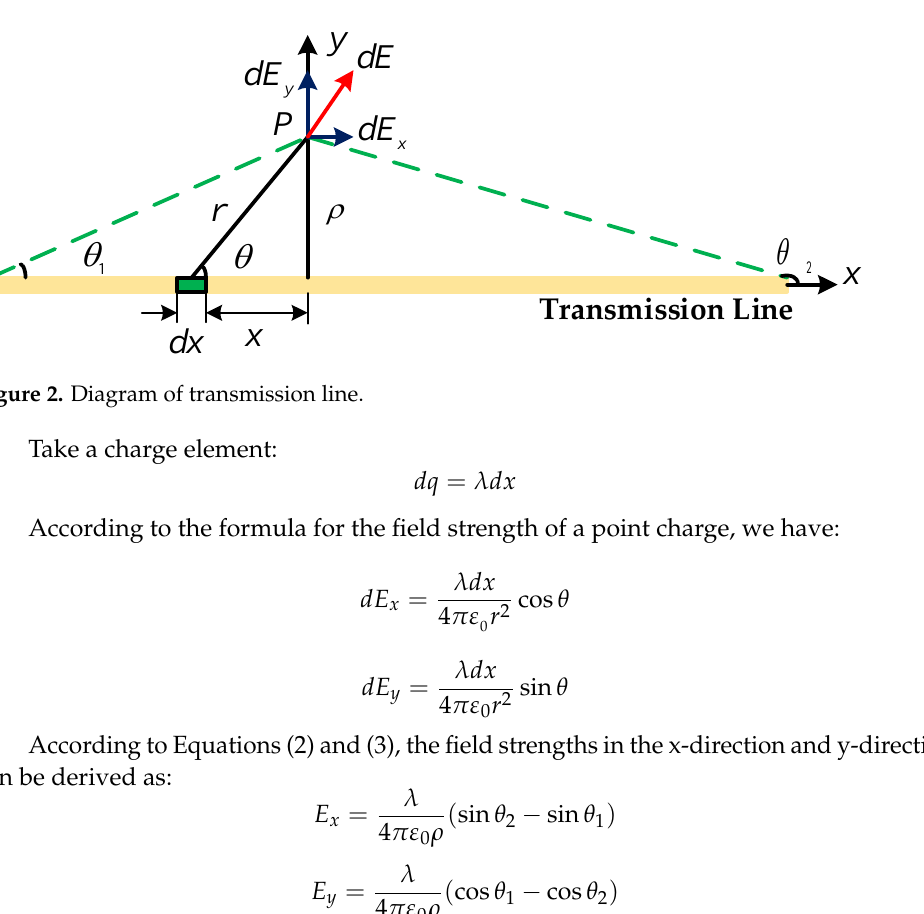
Figure 1. UAV patrol diagram.